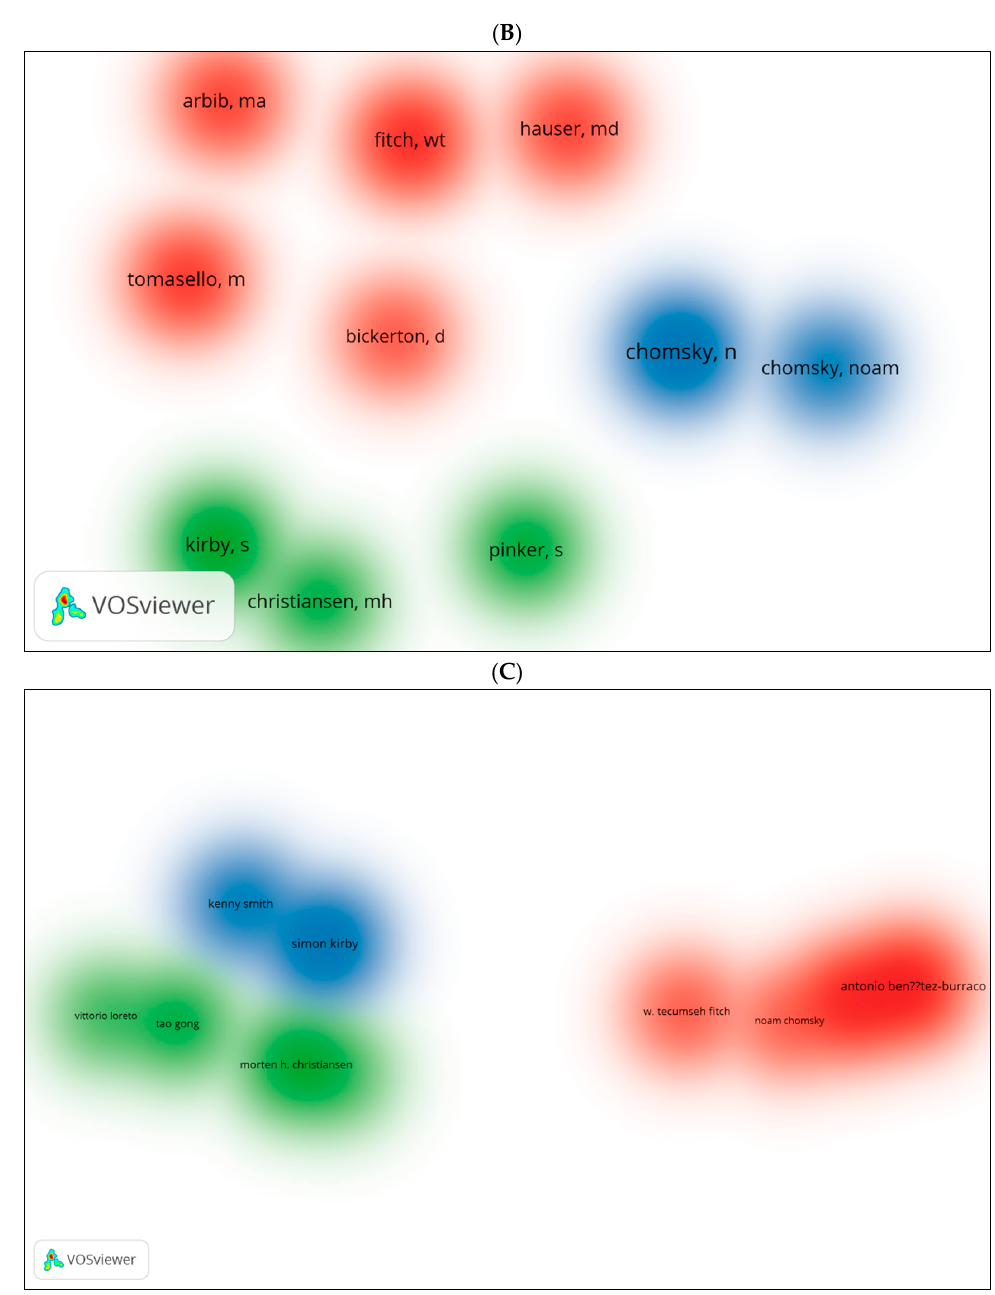
Figure 11. Co-citation by cited author density visualisation in biolinguistics. ( A ) (Scopus), ( B ) (WOS), ( C ) (Lens) citation by author density visualisation.